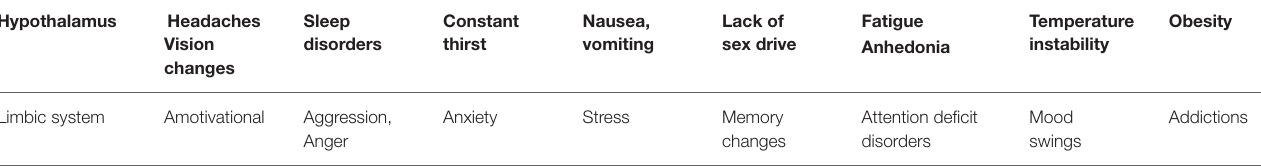
TABLE 2 | Symptoms in primary headache syndromes are referrable to the hypothalamic-limbic circuitry (Gowers,